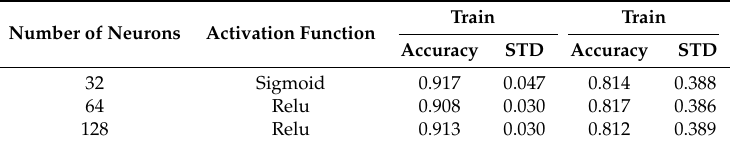
Table 1. Preliminary